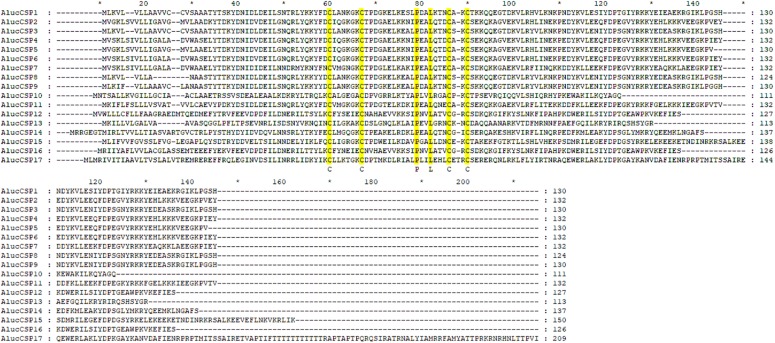
Multiple sequences alignment of CSPs of A. lucorum. Amino acid sequences were aligned by ClustalX 2.1 and edited by GeneDoc 2.7.0 software. Yellow boxes show conserved cysteine residues and other conserved residues. Accession numbers of CSPs of A. lucorum are listed in Table 2.